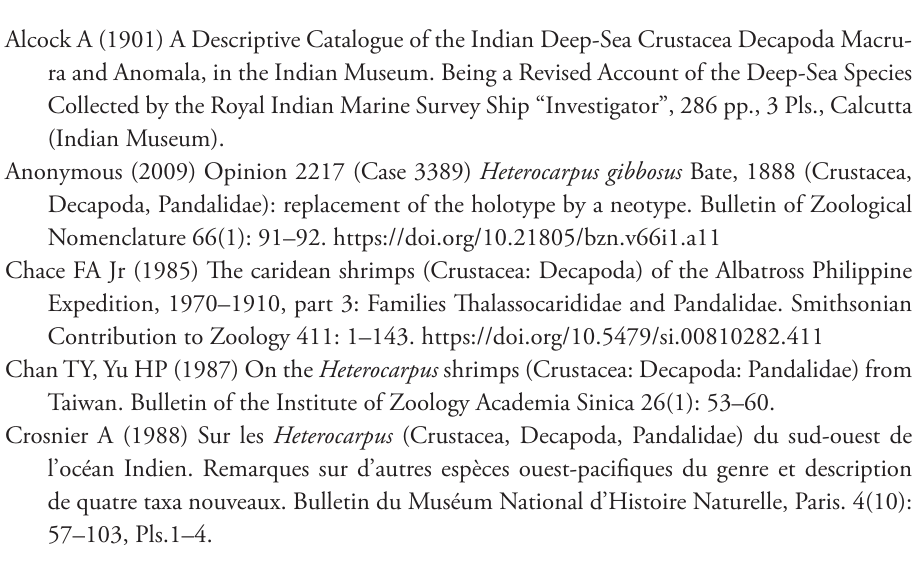
fig. 4, Yang et al. 2010: fig. 5E, Li and Chan 2013: fig. 1B; Kuberan et al. 2015: fig. 1). Although more differences are now enumerated between H. chani and H. gibbosus , it still cannot be deduced if the numerous reports of H. gibbosus from India in reality refer to that species or indeed solely represent H. chani , because all these records are too brief or did not list nor discuss any of the above distinctive characters. However, the “ H. gibbosus ” specimens from SW Cochin reported by George and Rao (1967)